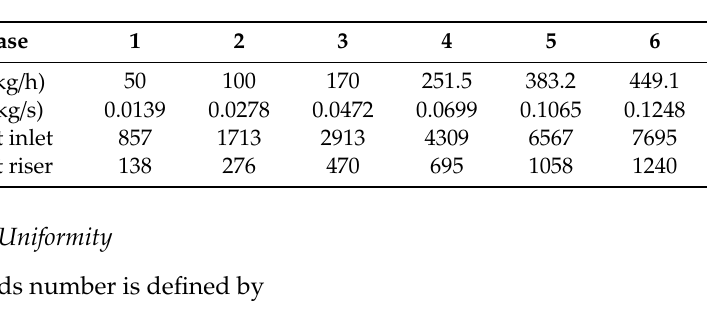
Table 1. Test cases